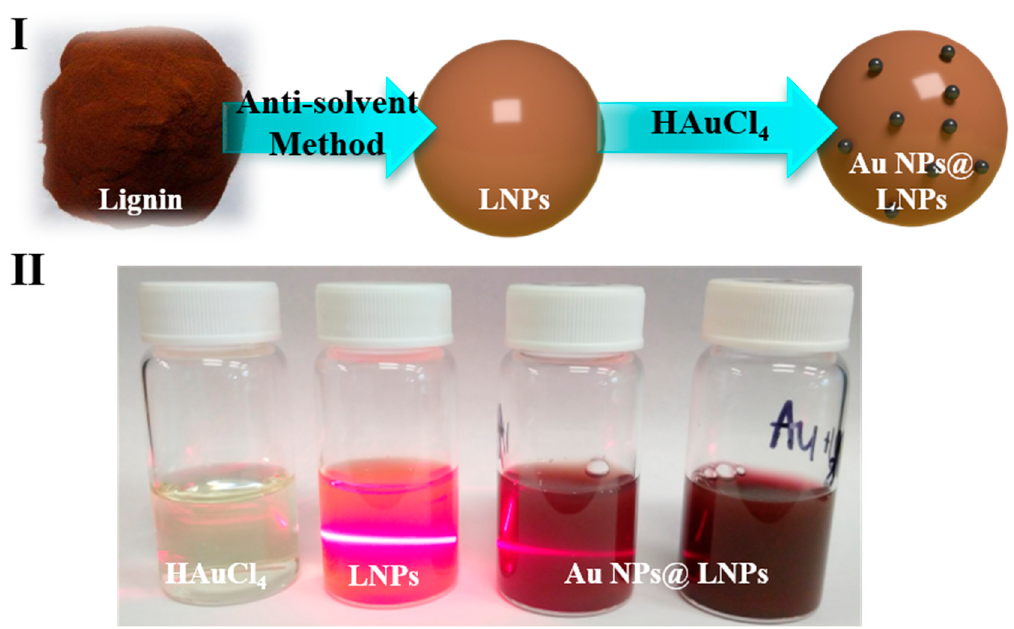
Figure 1. Schematics of the preparation of LNPs@AuNPs. ( I ). Preparation process of the LNPs@AuNPs, ( II ). Digital photo of the HAuCl 4 , LNPs, LNPs@AuNPs.